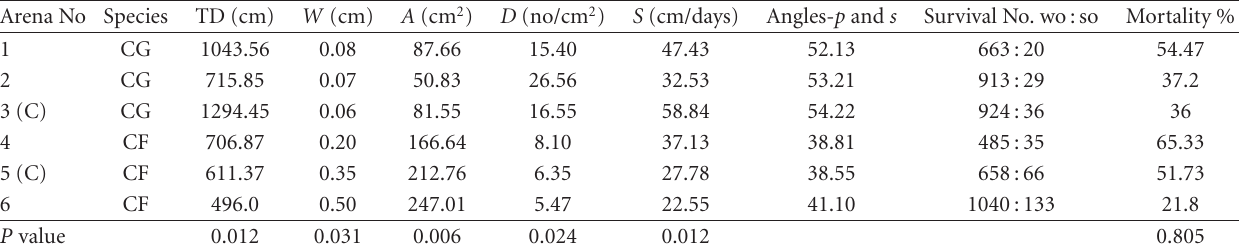
Table 2: Comparison of parameters measured in tunnel construction with C. formosanus (CF) and C. gestroi (CG). (TD: total length of tunnels constructed; W : mean width of tunnels; A : area occupied; D : numerical density within tunnels; S : speed of tunnel growth; p : primary tunnels; s : secondary tunnels; wo: workers; so: soldiers).